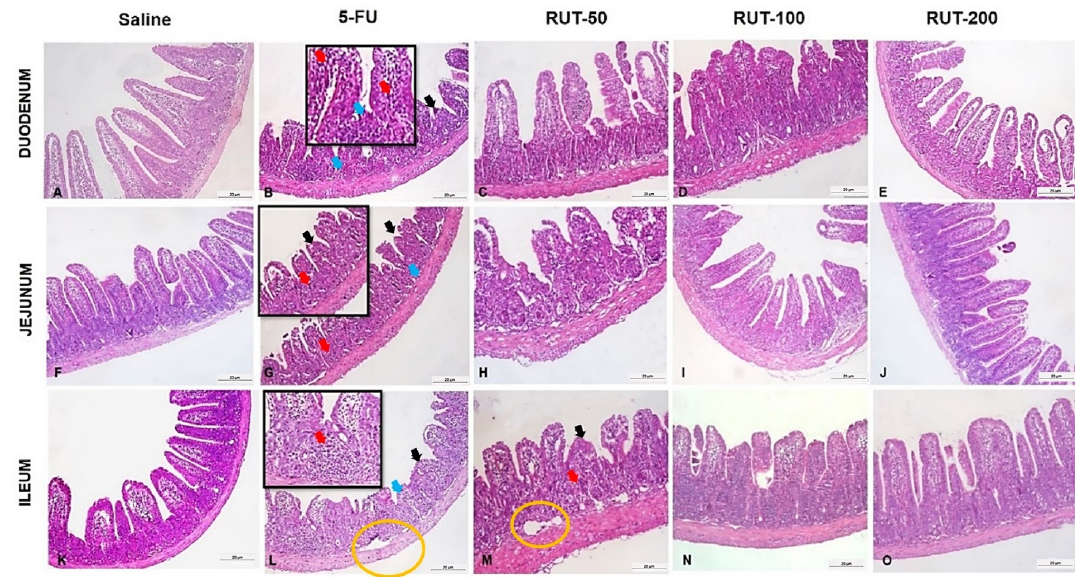
Figure 6. Histopathological analyses of intestinal segments of mice with 5-FU-induced intestinal mucositis. Horizontally, the duodenum is illustrated in ( A – E ), corresponding to the saline, 5-FU, RUT 50, 100, and 200 mg/kg groups, respectively. The jejunum is illustrated in ( F – J ), representing the saline, 5-FU, RUT 50, 100, and 200 mg/kg, groups, respectively. The ileum is illustrated in ( K – O ), representing the saline, 5-FU, RUT 50, 100, and 200 mg/kg, respectively. Black arrows: Shortened villi; red arrows: inflammatory infiltrates, blue arrows: loss of crypt architecture, and yellow circle: edema. In all segments, 5-FU induces shortened villi, loss of crypt architecture, and intense inflammatory infiltration. Histological changes are notably reduced following pretreatment with RUT 200 mg / kg, especially in the duodenal and jejunal segments. 5-FU, 5-fluorouracil; RUT, rutin.